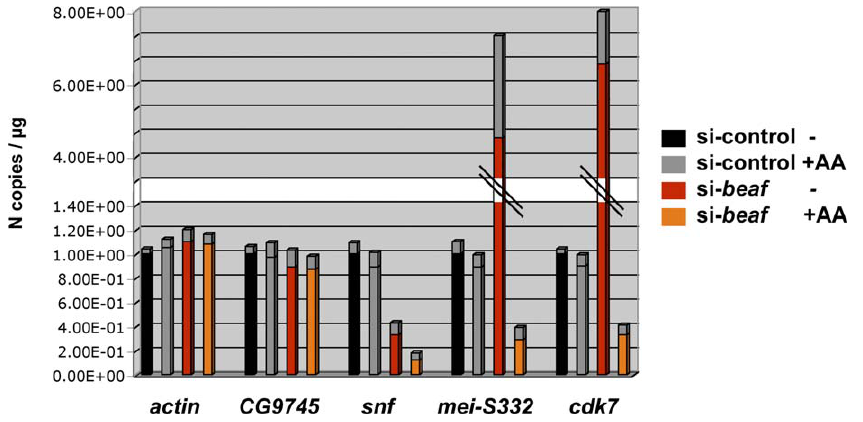
Figure 8. BEAF Dual-Cores Protect Genes from Chromatin Repression Quantitative RT-PCR analysis of the expression of—from left to right— actin , CG9745 , snf , cdk7 , and mei-S332 in control cells (black and grey bars, in the absence or presence of 5 l M AA, respectively) or BEAF-depleted cells (red and orange bars, in the absence or presence of 5 l M AA, respectively). The y - axis shows the number of copies of amplification products per l g of RNA which was normalized for each gene in control cells, where N ¼ 1 corresponds to 11,200 copies of actin , 12,900 copies of CG9745 , 75,430 copies of snf , 64,500 copies of mei-S332 , and 129,800 copies of cdk7 . Experimental error is denoted by the differentially colored portion (gray) at the top of each bar.